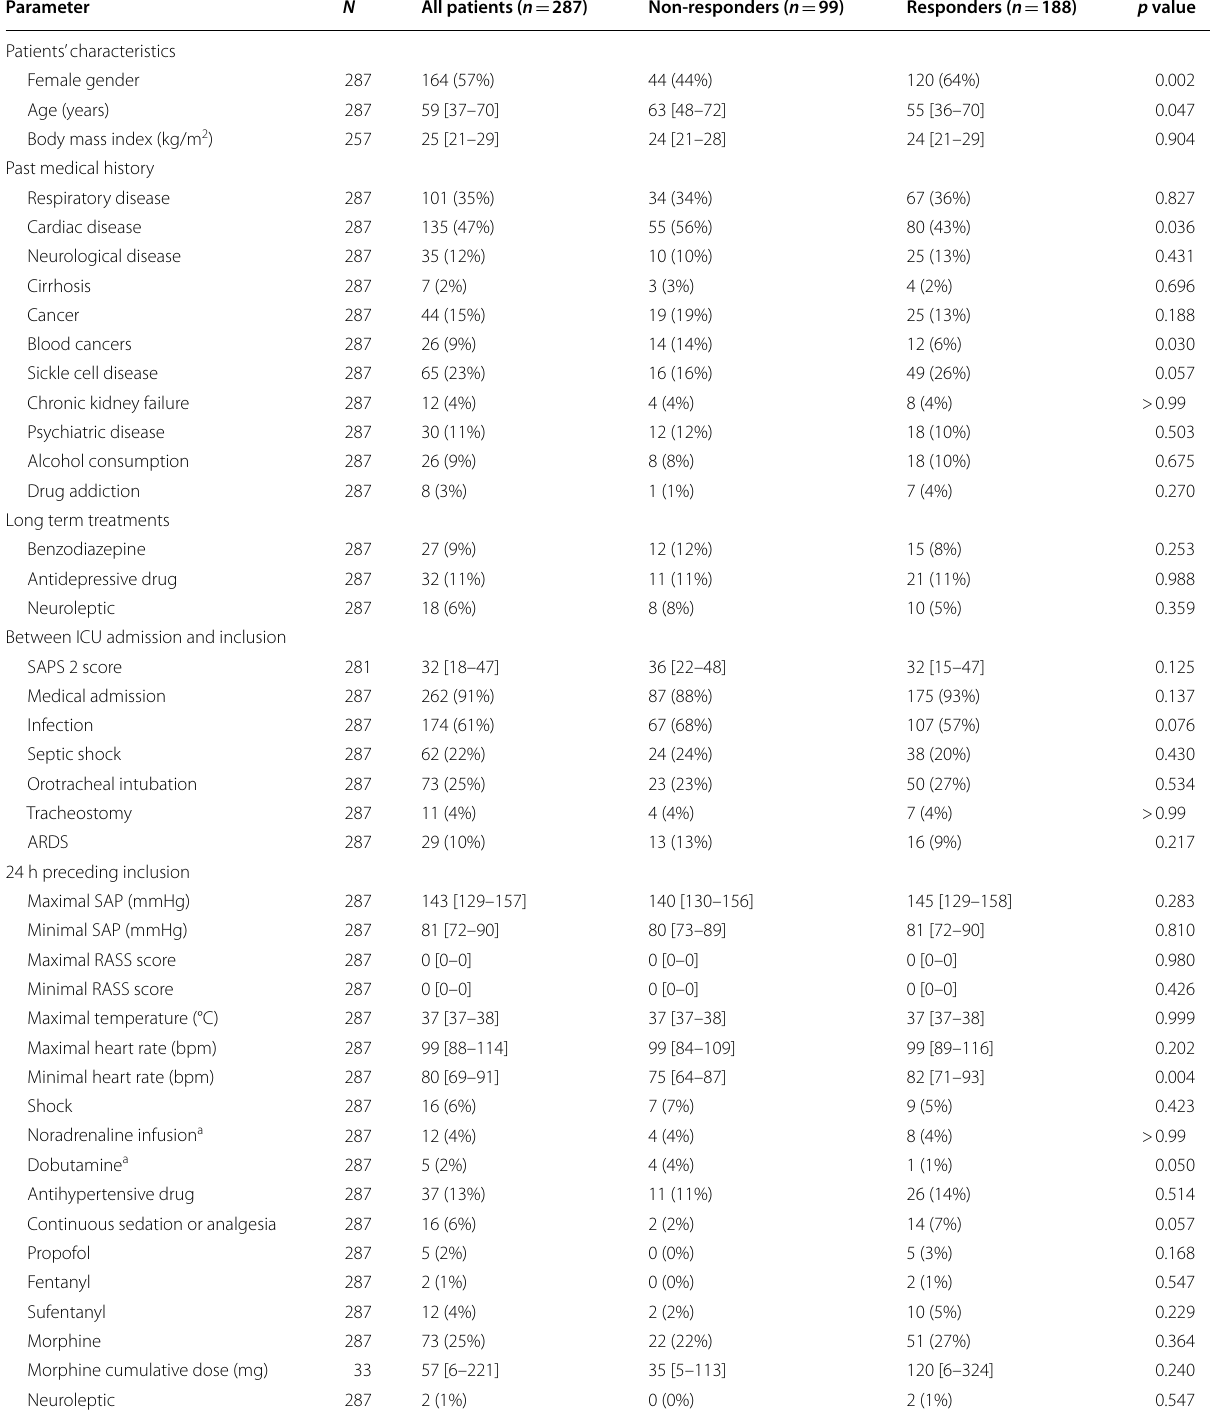
Table 2 Characteristic of critically ill patients, overall and depending on their response to corporeal rehabilitation